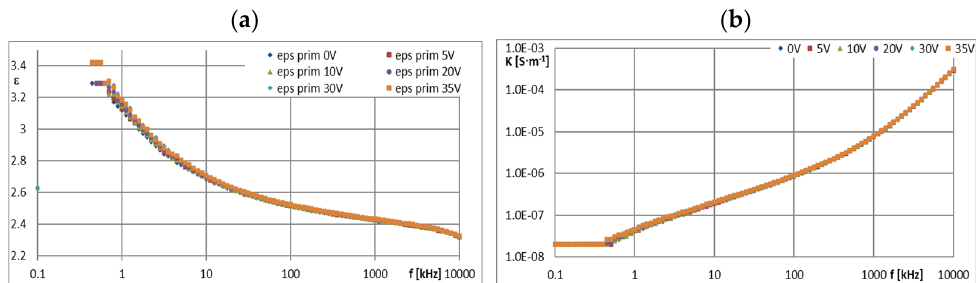
Figure 10. Characteristics: ( a ) ε = f( f ) and ( b ) κ = f( f ) for PAO6 + CJ008 at different values of U .